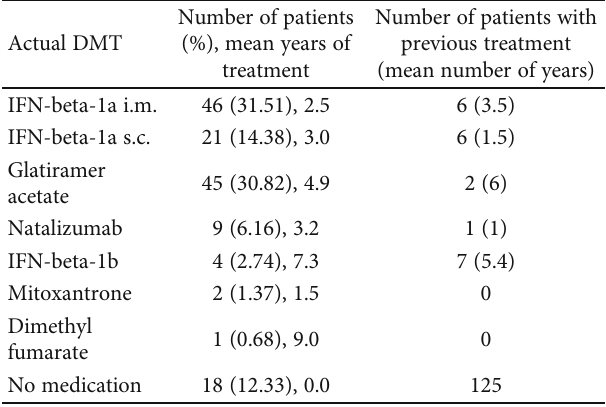
Table 1: Baseline patients ’ characteristics. Table 2: Treatment details for studied